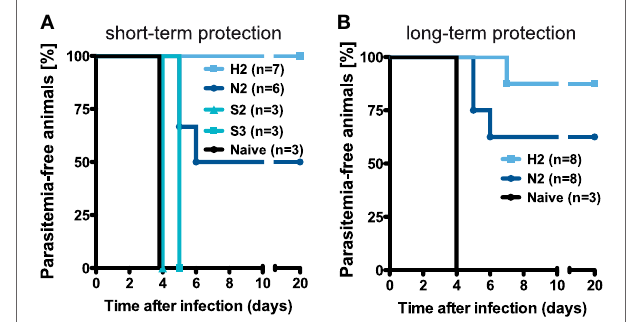
FigUre 4 | Protective efficacy of different vaccination regimens. (a) Schematic of the protocol determining the groups of mice that were challenged. (B,c) Percentage of protected animals receiving either two or three injections with the N-, H-, or S-dose, respectively. Mice were challenged by i.v. injection of 1 × 10 3 infectious Pb ANKA sporozoites in a total volume of 100 µl PBS on day 14 [ (B) , short-term] and more than 100 days post last injection [ (c) , long-term] with protection defined as the absence of blood-stage parasites. See also Table S2 in Supplementary Material.